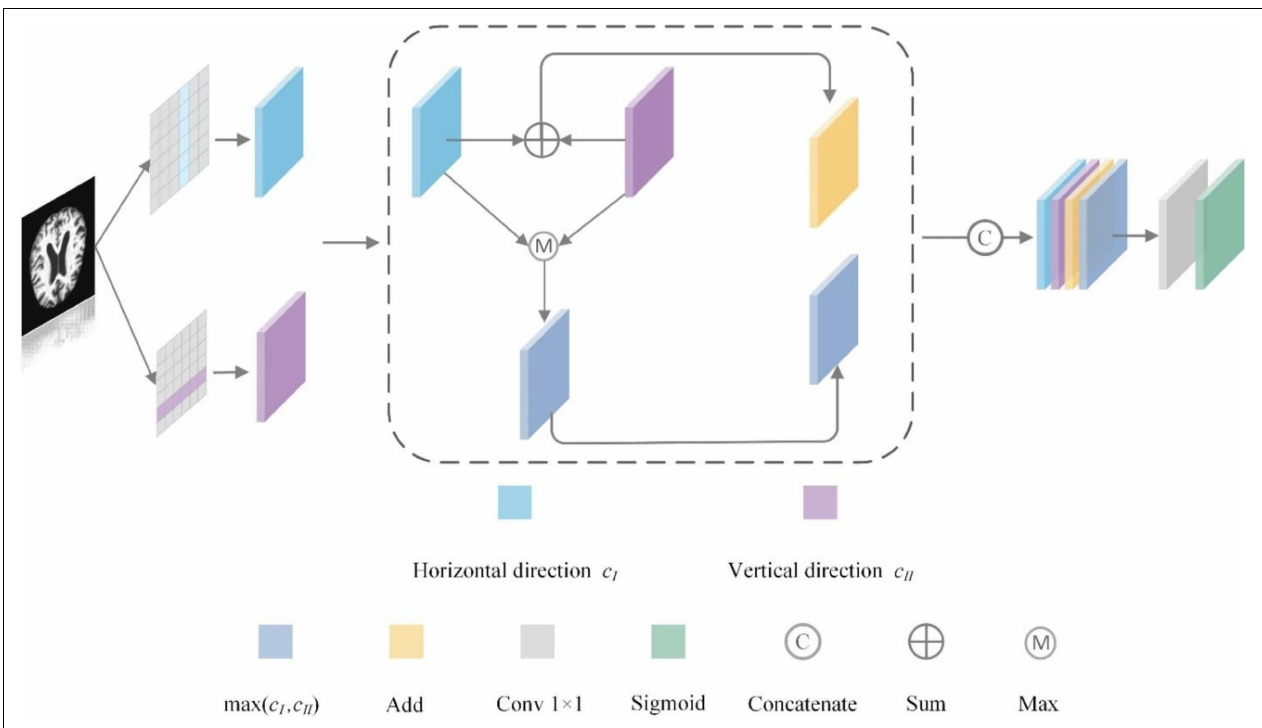
FIGURE 9 | Space conversion attention mechanism structure.